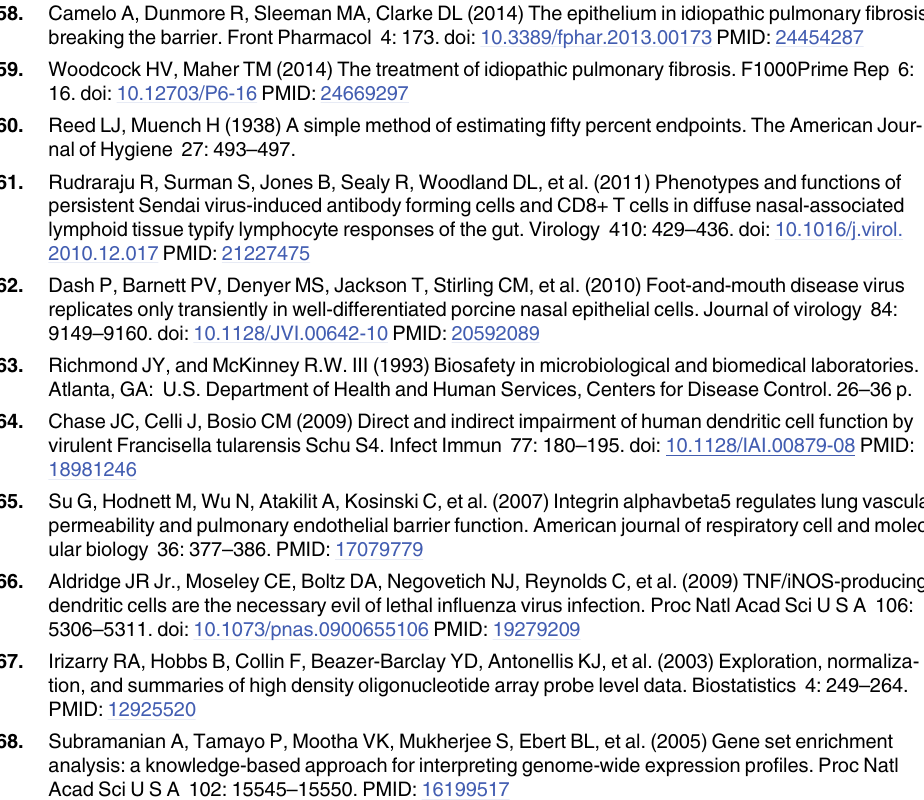
PLOS Pathogens | DOI:10.1371/journal.ppat.1005804 August 9,